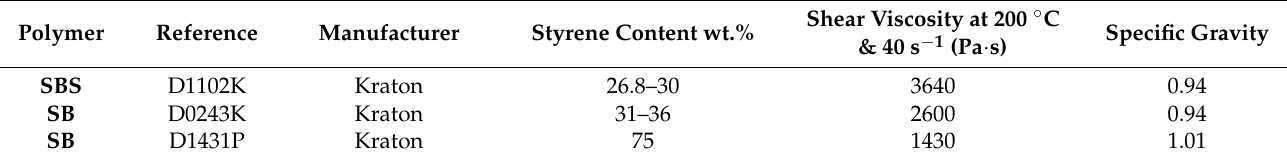
Table 1. Properties of SB and SBS